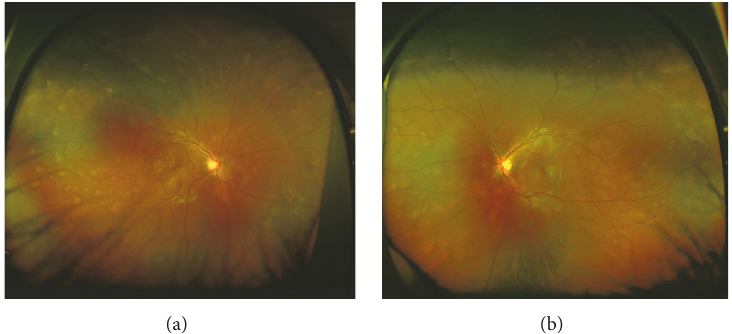
Figure 1: Color fundus photographs with the 200Tx ultra-wide-field retinal imaging system (Optos) at the initial examination demonstrating multiple placoid subretinal lesions scattered from the posterior pole to the peripheral retina bilaterally. Foveal subretinal fluids are present in both eyes. (a) The right eye. (b) The left eye.